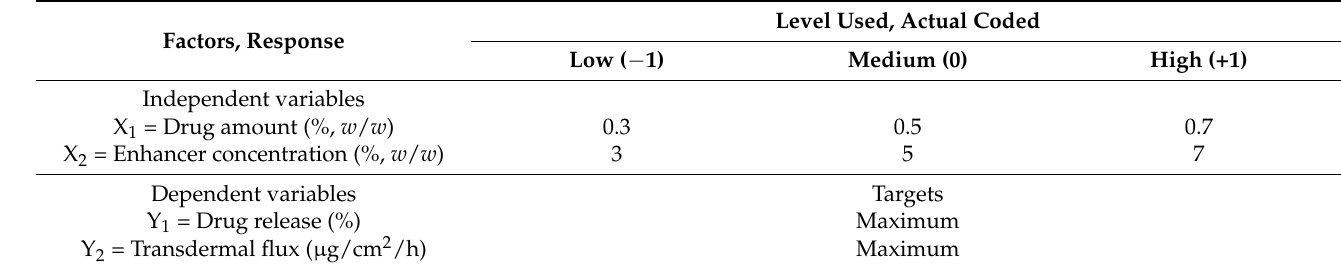
Table 1. Level and actual coded values used for optimization.